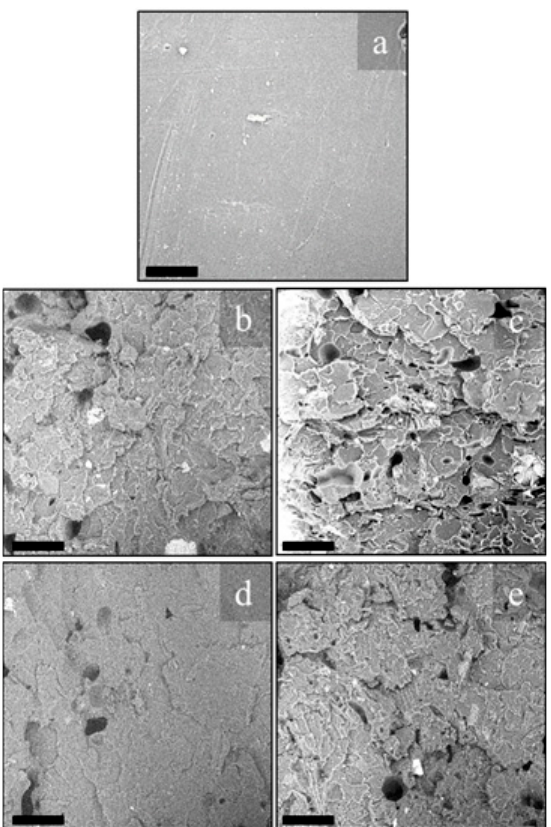
Figure 10. Fracture surfaces after tensile tests of PLA ( a ), OFI10 ( b ), OFI20 ( c ), POL10 ( d ) and POL20 ( e ) 3D-printed samples; scale bar 100 μ m.